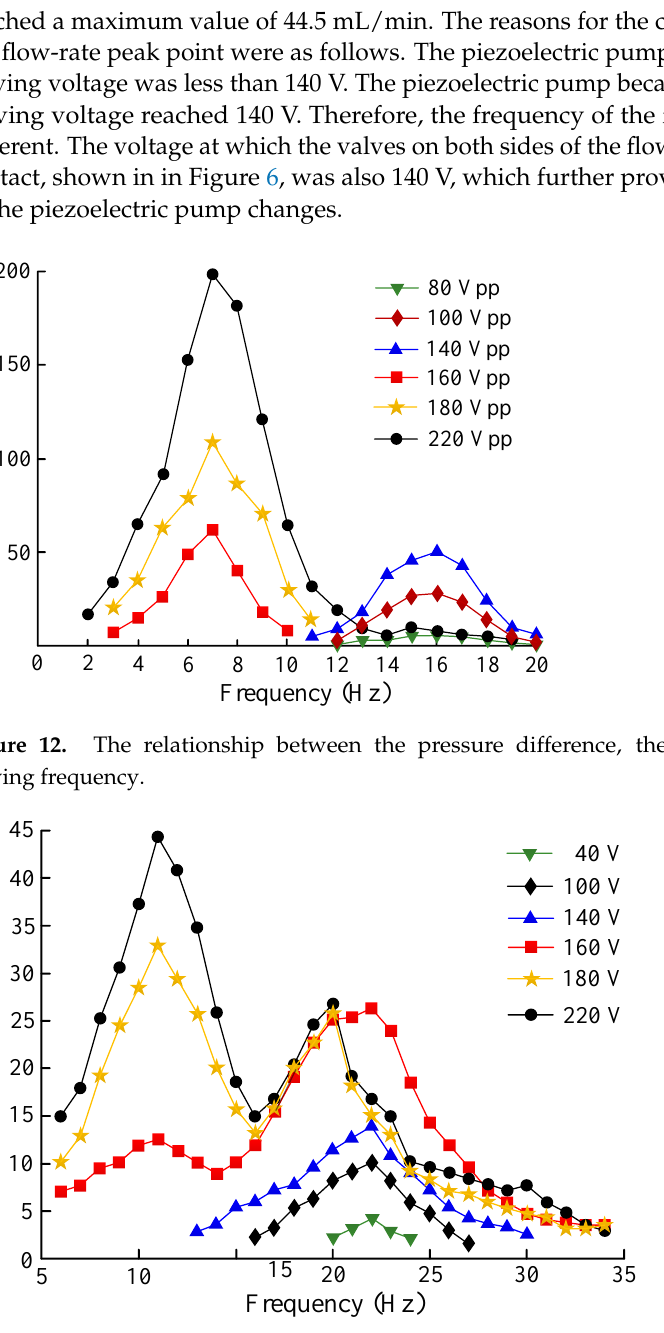
(b) Figure 11. The frequency − scanning curve and the vibration mode of the resonance point of the